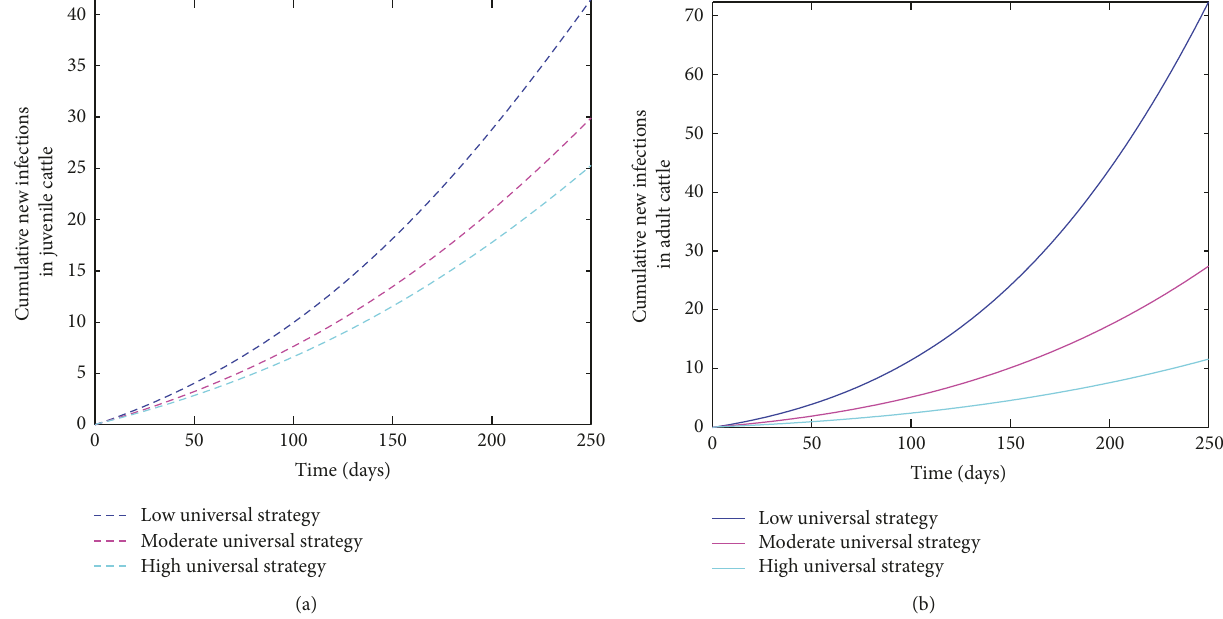
Figure 8: Simulation of the bovine anaplasmosis model (12) as a function of time using the universal-control strategy. (a) Cumulative new infections in juvenile cattle; (b) cumulative new infections in adult